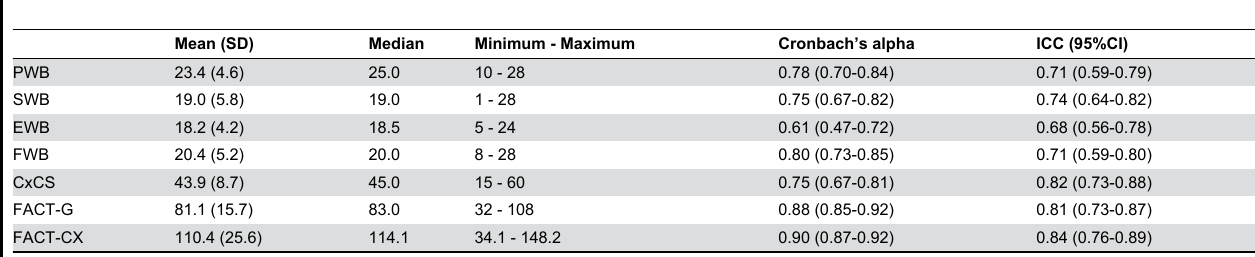
Table 3. Descriptive analysis of the scales of the FACT-CX questionnaire, the corresponding Cronbach’s alpha coefficients, and the intraclass correlation